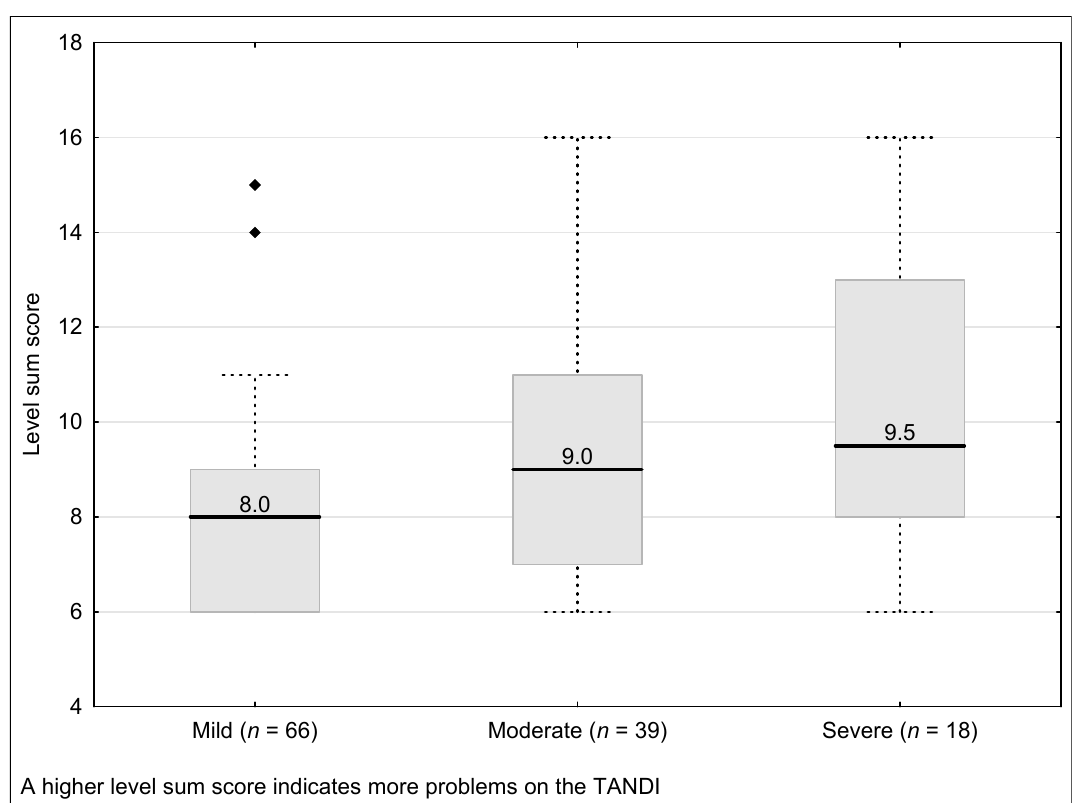
Figure 2. Discriminate validity of the TANDI Level sum score across the severity of health condition (Total Sample N = 203). Health condition indicates attendance at a paediatric hospital for management of an acute or chronic health condition. Boxes indicate first to third quartiles, the dividing line the median, whiskers the non-outlier range and markers the outliers.